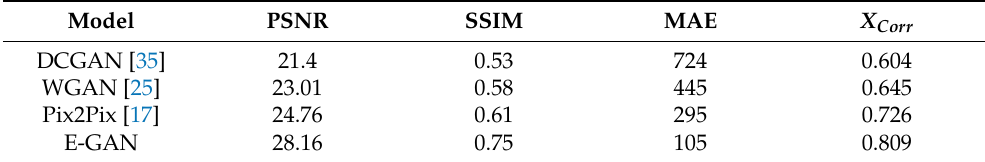
Table 2. The evaluation metrics of different state of the art methods on ADNI and the proposed method after 1000 epochs.